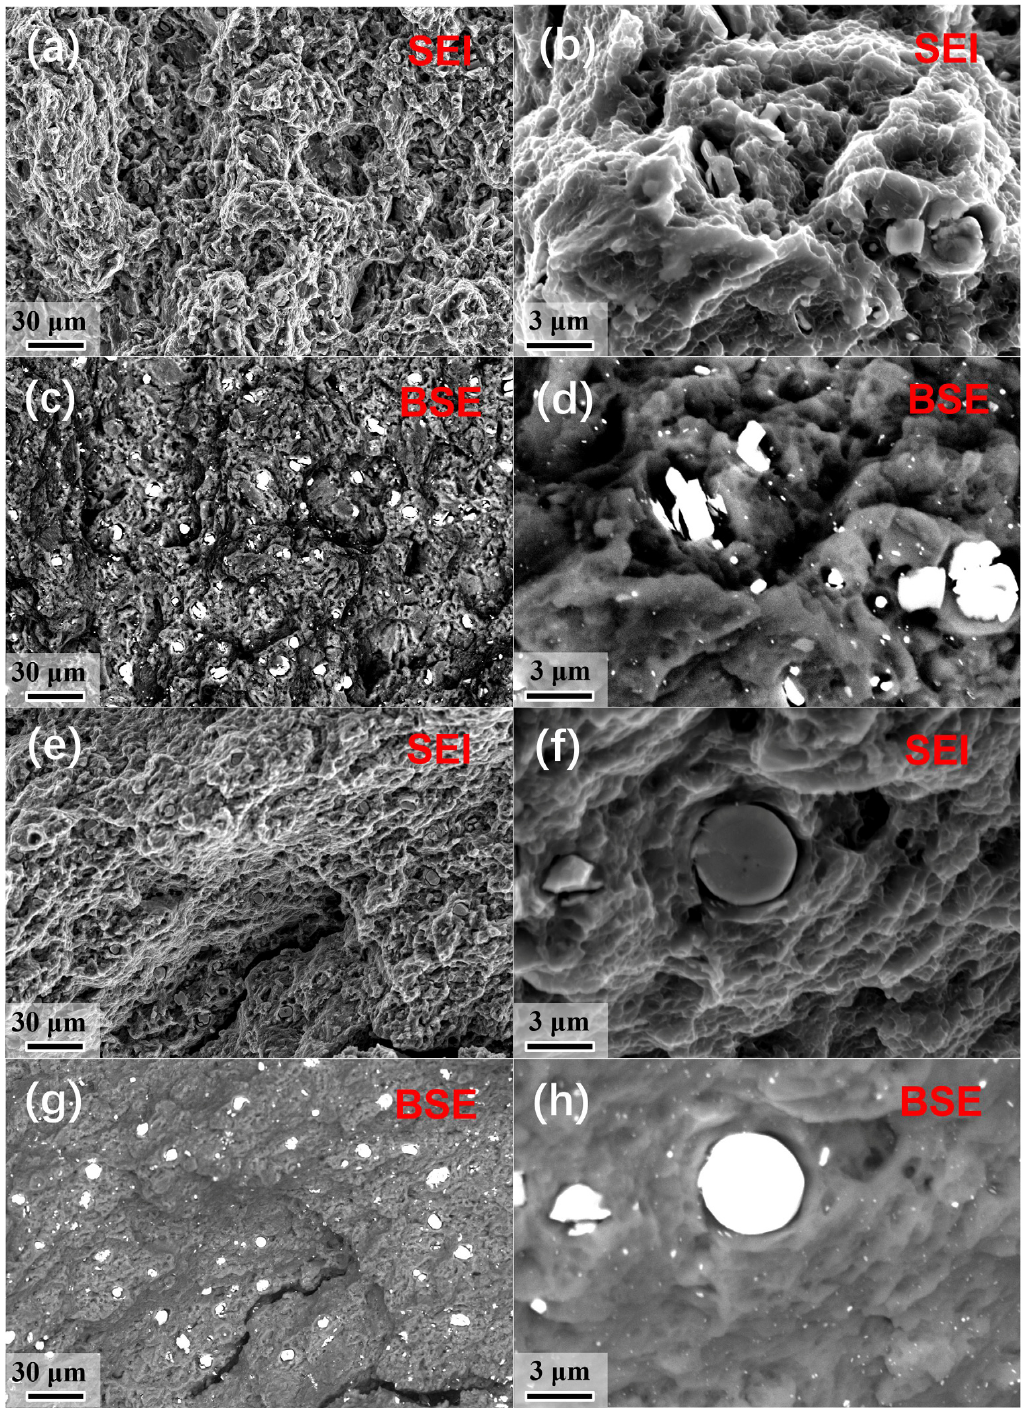
Figure 8. SEM fracture morphology of ( a – d ) as-extruded and ( e – h ) CRed AB83 alloy after failure during the tensile test.